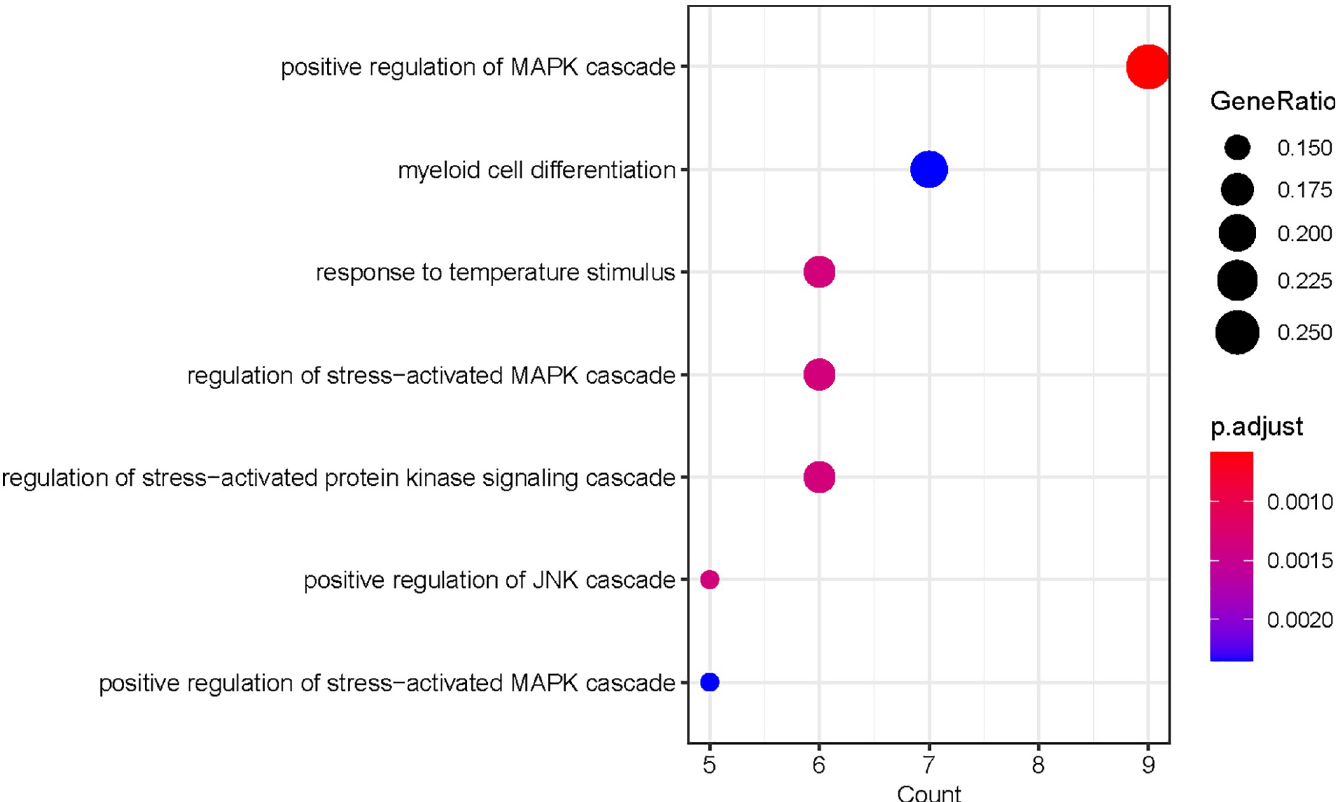
Fig 4. Gene oncology analysis of the genes in the green module. Several signal pathways and leukocyte-related process were enriched.